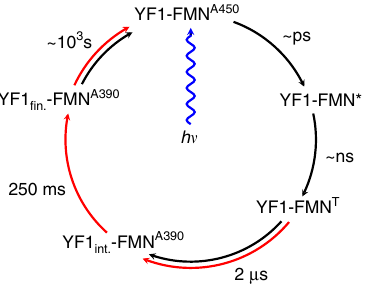
Fig. 3 Structural photocycle of YF1. Within pico- to nanoseconds after illumination, all rearrangements are con fi ned to the chromophore and its immediate surroundings (YF1-FMN * , YF1-FMN T ). The fl avin triplet state (YF1-FMN T ) decays into the thioadduct state, which is synchronous with protein conformational changes (YF1 int. -FMN A390 ). The protein conformation changes again within milliseconds, without any response from the chromophore (YF1 fi n. -FMN A390 ). Eventually the resting state (YF1-FMN A450 ) is recovered. Spectroscopic transitions of the chromophore are marked as black arrows and structural transitions of the protein as measured by X-ray solution scattering are marked as red arrows , fi nal structural state YF1 fi n. is not associated with any detectable changes in UV/vis absorption spectroscopy.